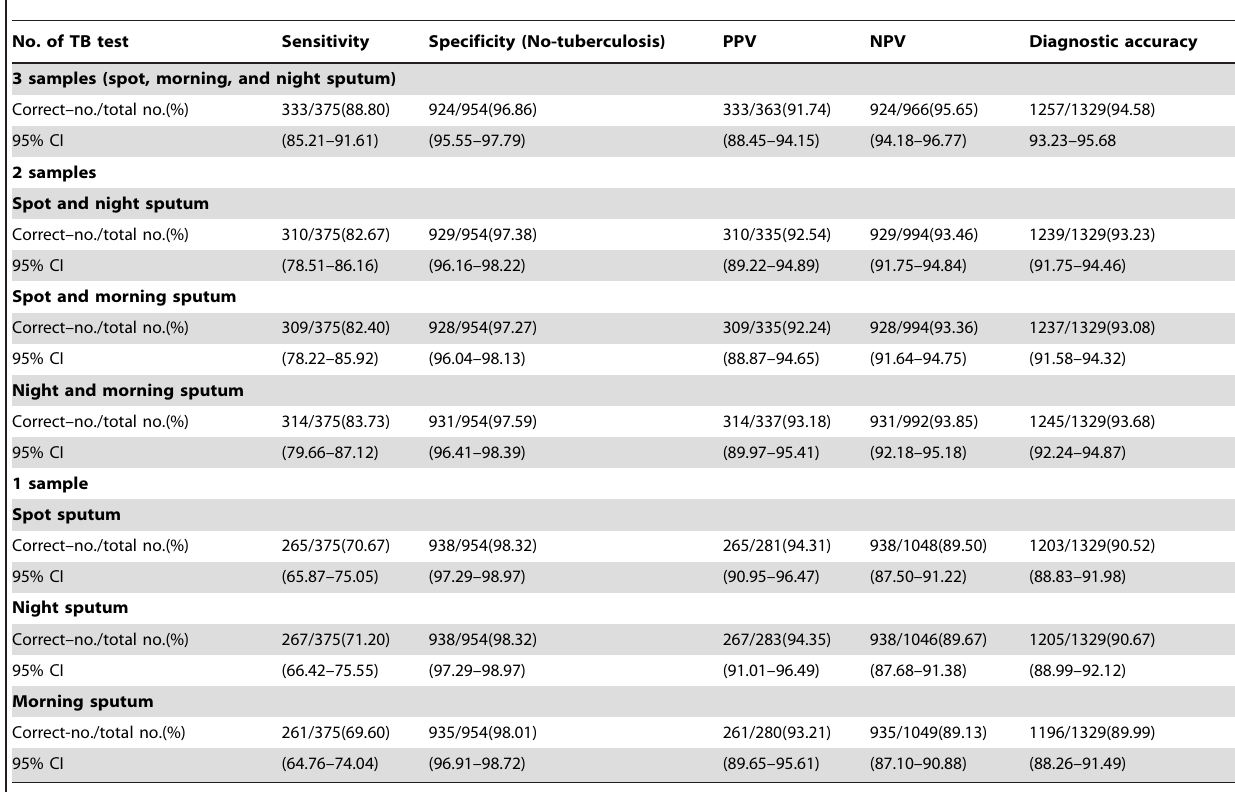
Table 3. Performance of PURE-LAMP based on different sputum and different sputum